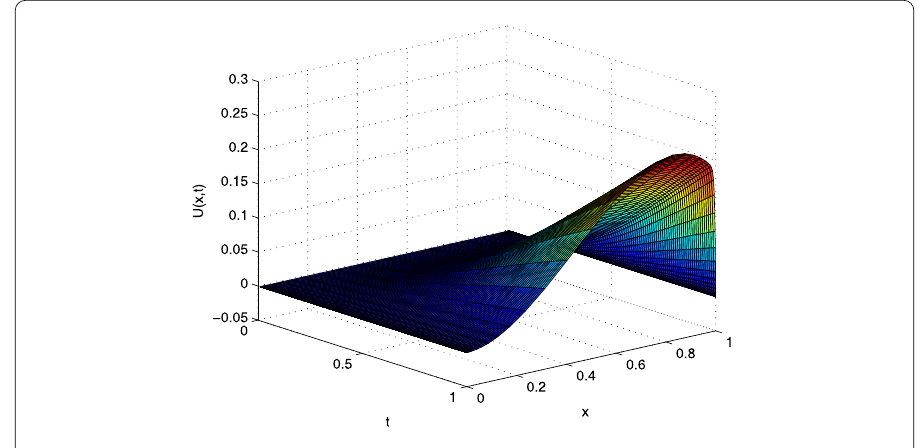
Figure 5 Numerical solutions with α = 0.2, (cid:4) = 2 –8 , N = 32, τ = 1/100